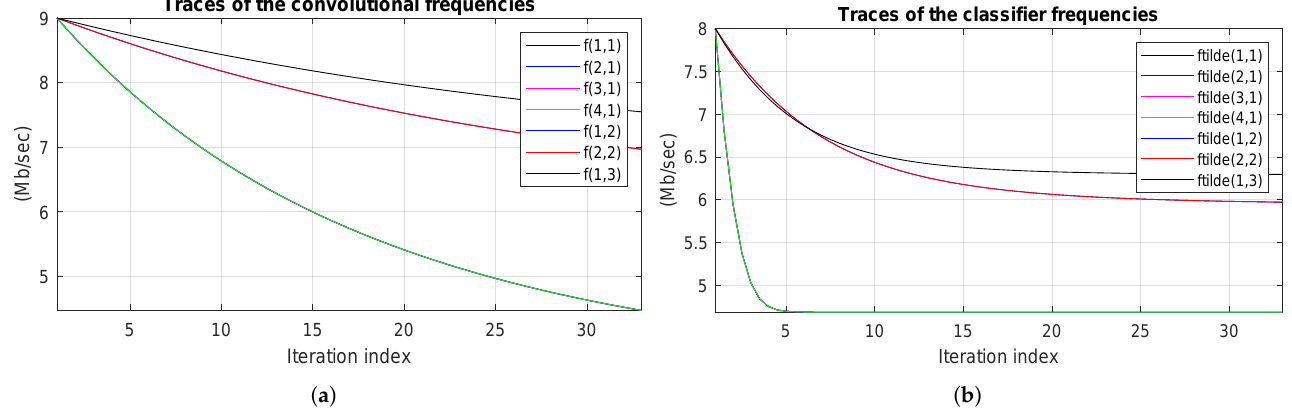
Figure 9. Traces under topology T 1 of the obtained frequencies of the: ( a ) convolutional processors and ( b ) classifier processors. The last values of the traces in Figure 9a,b, i.e., the optimized frequencies of the